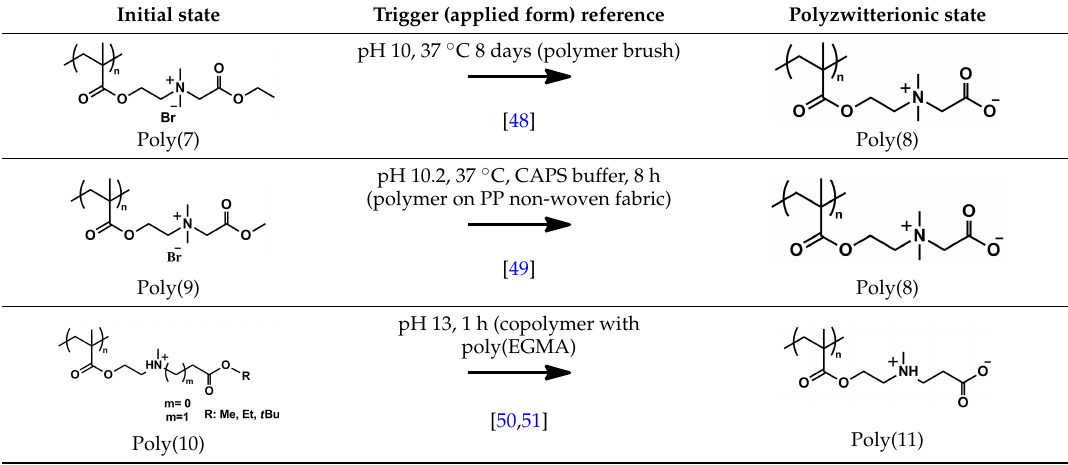
Table 1. Irreversible pH-triggered (meth)acrylic-based switches containing polyzwitterionic state.